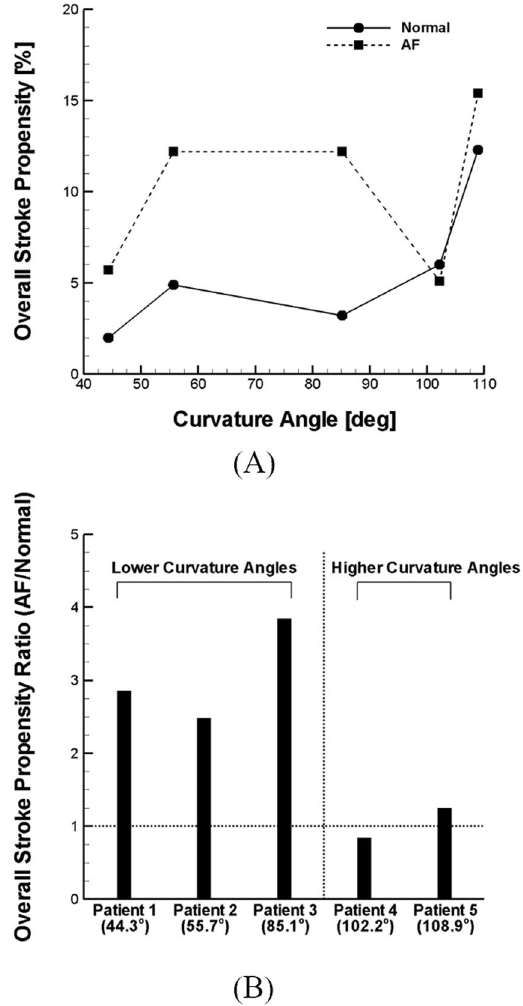
Figure 5. ( A ) Stroke propensity with curvature angle under the normal and AF flow condition. ( B ) Stroke propensity alteration induced by AF with curvature angle compared to the normal flow